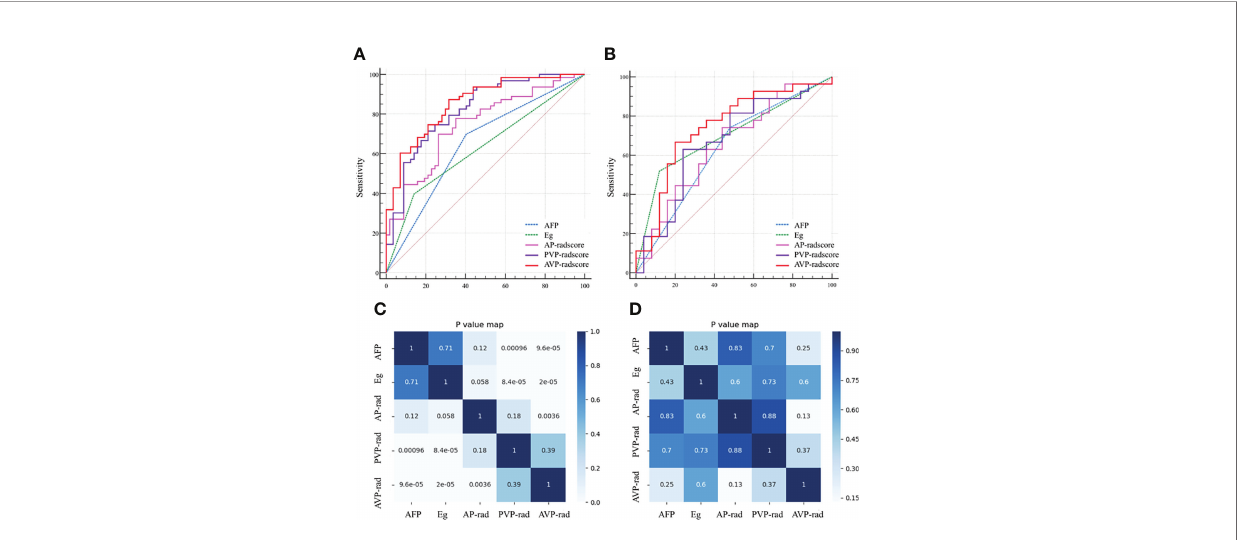
FIGURE 2 | Receiver operating characteristics (ROC) curves of AP, PVP, AVP and clinical independent predictors in the training (A) and validation (B) groups; Heat maps of these major parameters in the training (C) and validation (D) groups. AP, arterial phase; PVP, portal venous phase; AVP, arterial phase combined with portal venous phase. AFP, alpha-fetoprotein; Eg, Edmondson